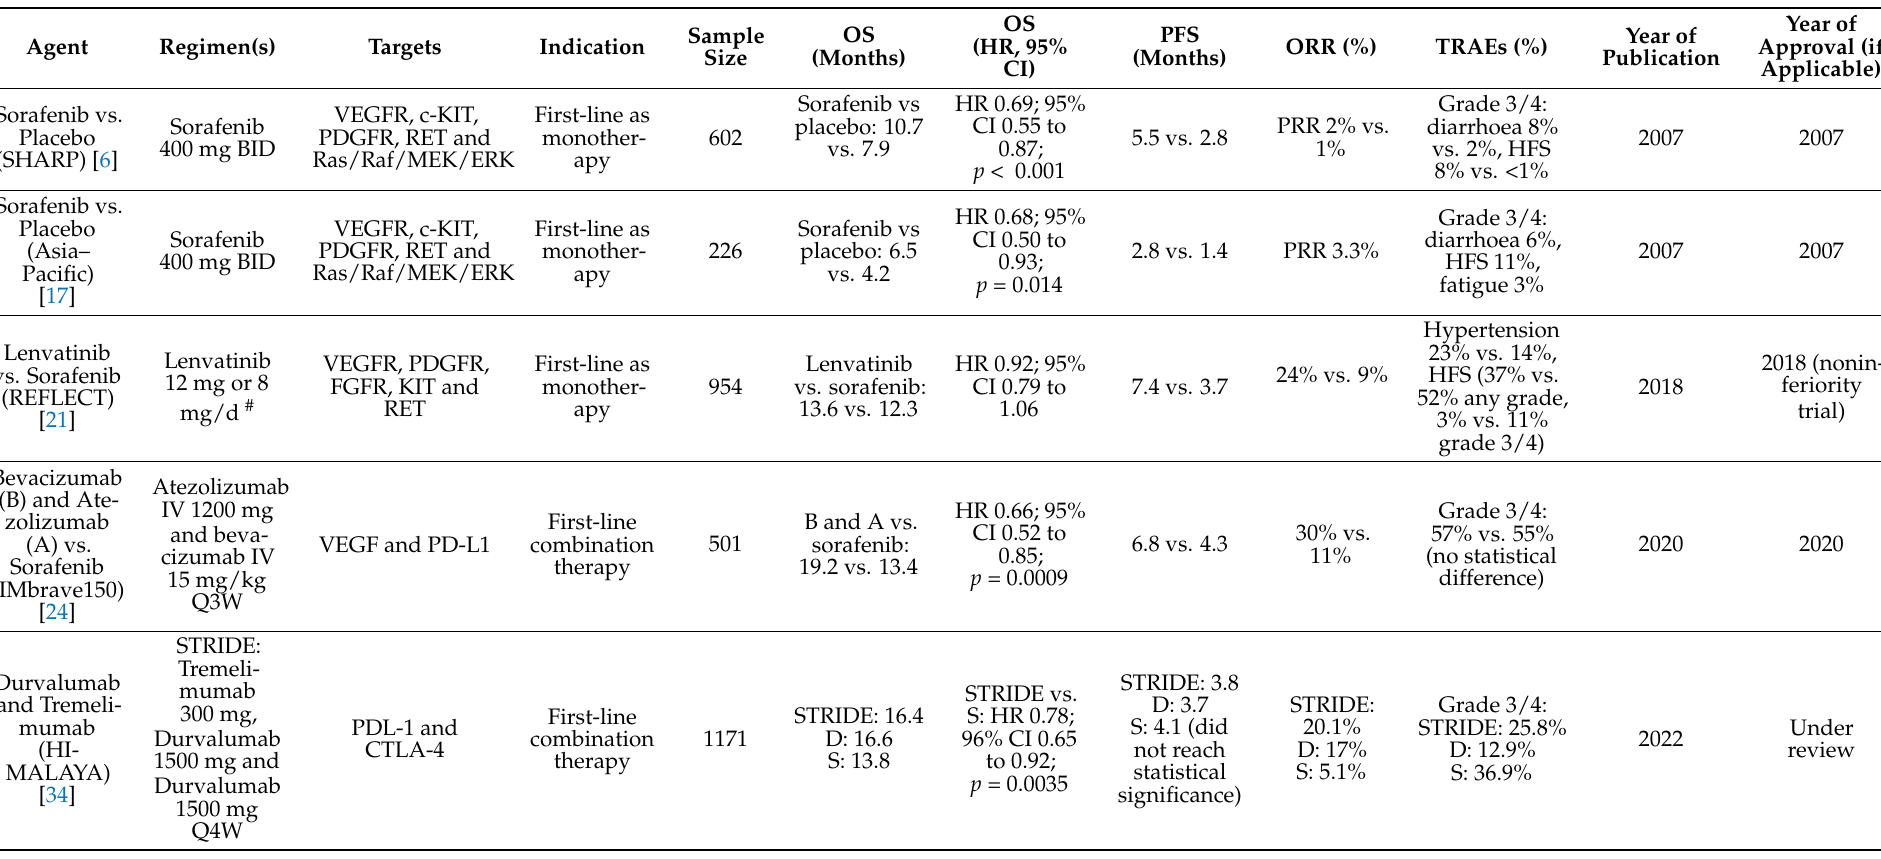
Table 1. First-line systemic therapies for advanced